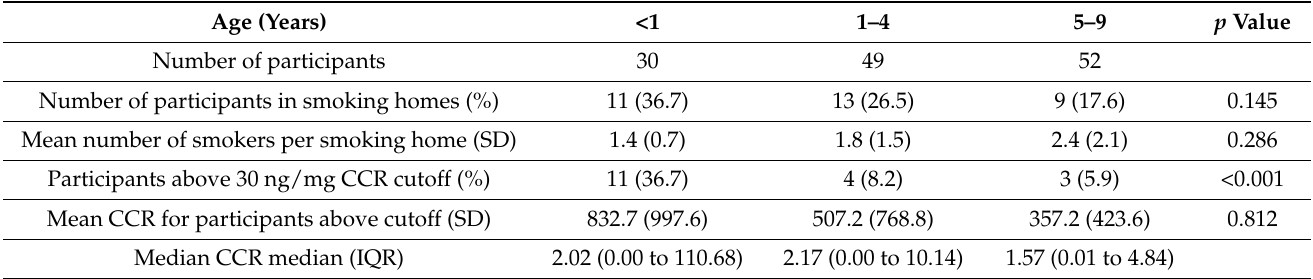
Table 2. CCR ratios of patients by age.